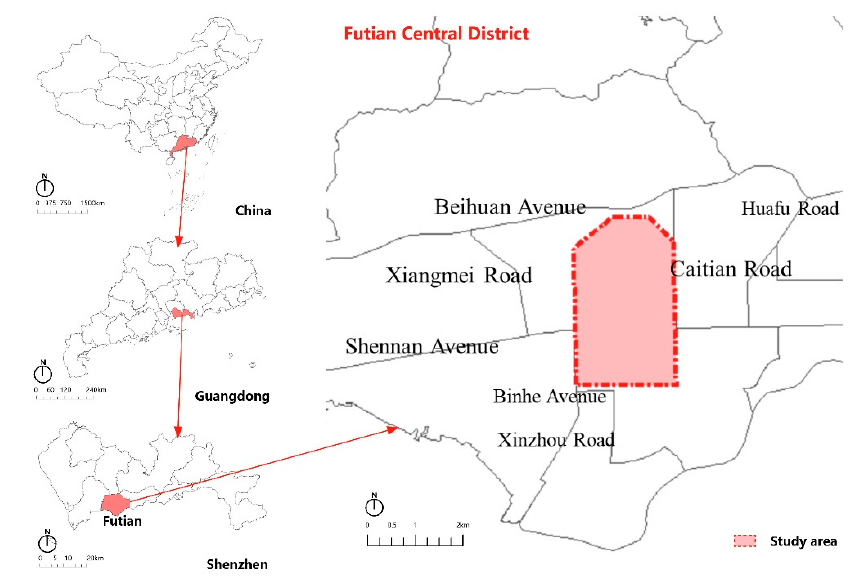
Figure 1. Location and scope of study case.